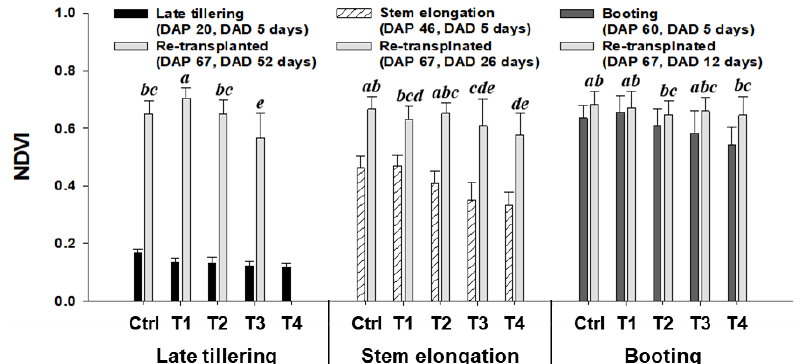
Figure 7. Recovery of rice after toluene exposure. The left mean NDVI was measured at 5 days after damage at each growth stage, and the right mean NDVI (recovery) was measured at 67 days after planting. The small letters refer to the significant differences in the mean NDVI of 14 retransplanted rice (α = 0.05). The mean NDVI within the same small letter is not significantly different at Tukey’s HSD ( p > 0.05).